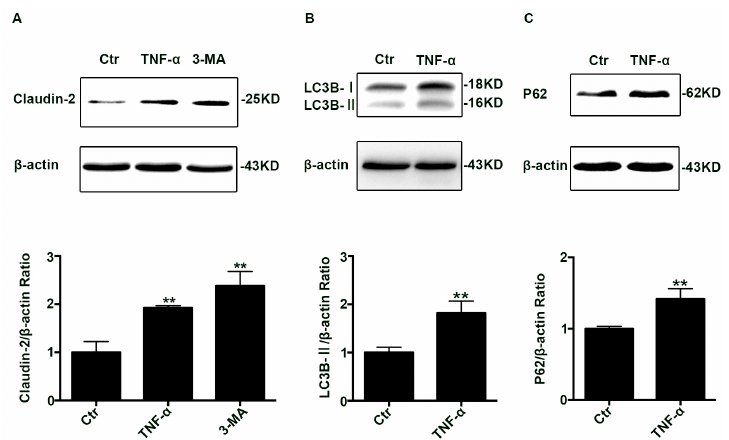
Figure 1. Change of claudin-2, LC3B-II, and P62 protein in TNF- α treated Caco-2 cell monolayers. ( A ) Western blotting analysis of caludin-2 in Caco-2 cell monolayer after TNF- α (10 ng/mL) administration or 3-MA (5 mM) treatment for 48 h. ( B , C ) Western blotting analysis of LC3B-II and P62 in Caco-2 cells after TNF- α (10 ng/mL) administration for 48 h. β -actin was used as an internal control. Data were shown as mean ± SD and replicated three times. ** p < 0.01 versus control group. Ctr, control group.